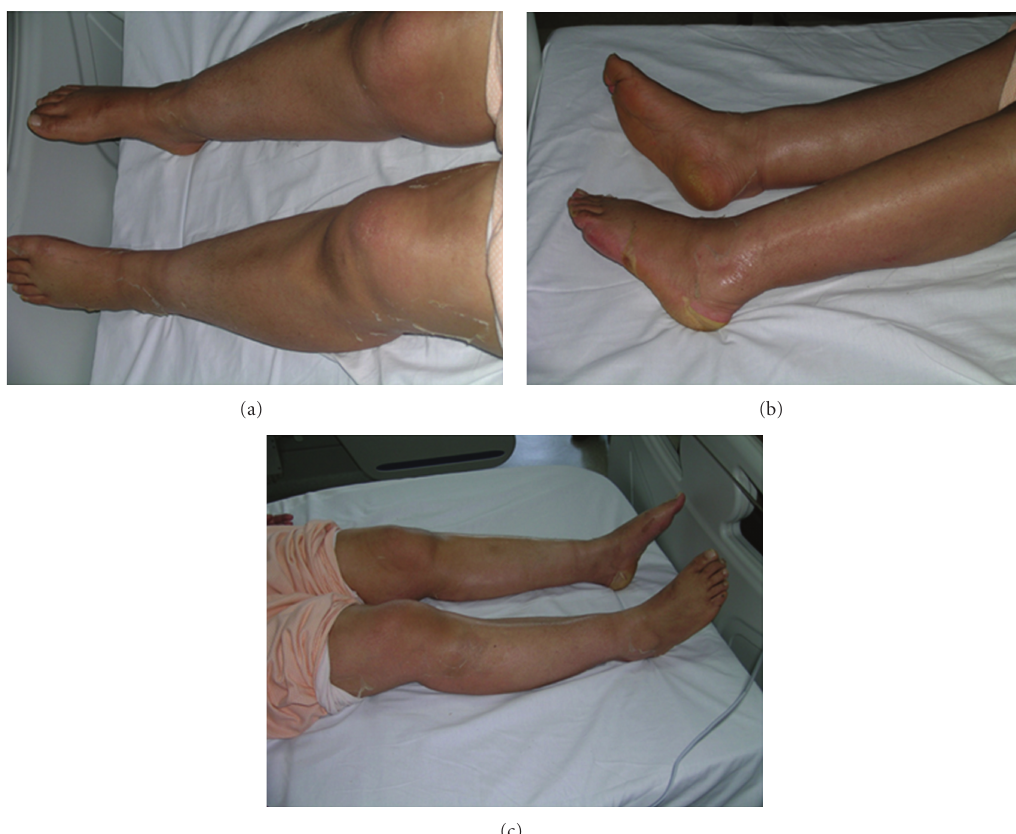
Figure 4: Di ff use erythema and desquamation most evident at the plantar surfaces of the lower extremities.